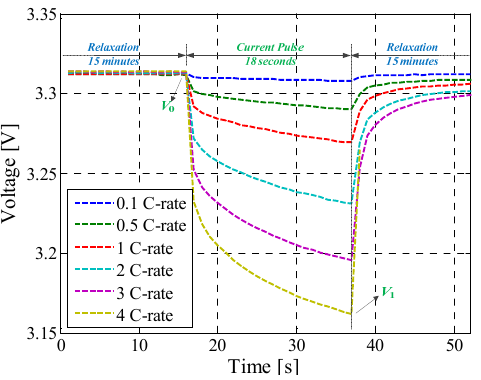
Figure 8. Measured voltage response of the LFP battery at discharging current pulses of different C- rates ( SOC = 50%, T = 25 °C).